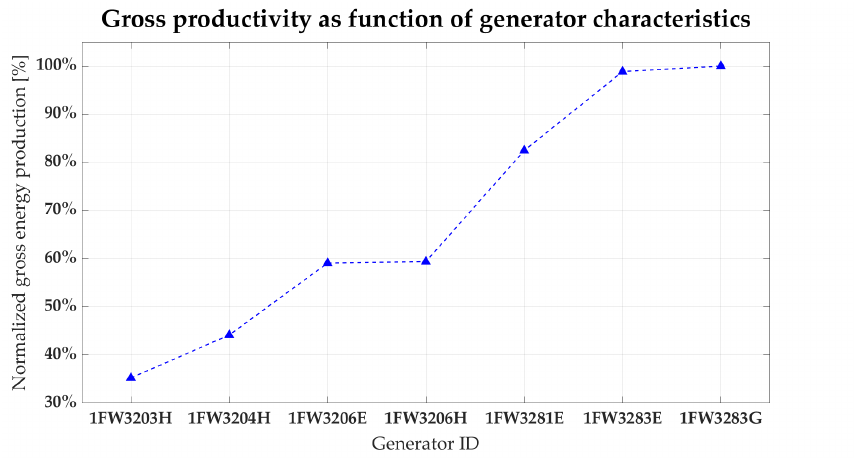
Figure 7. Gross productivity as function of generator